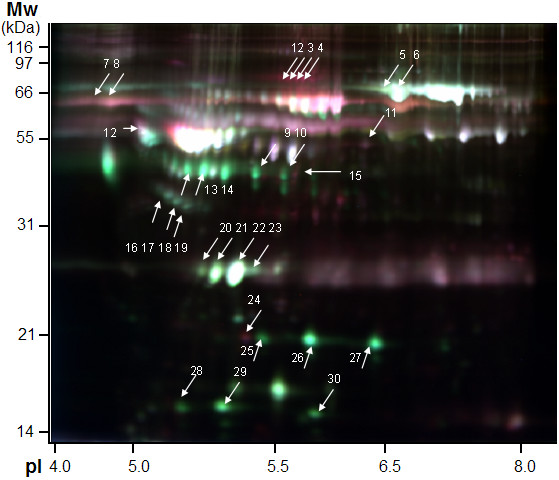
False-colored DIGE gel image of plasma proteins from normal and patient groups. Cy2 (blue) image of proteins from internal standard plasma; Cy3 (green) and Cy5 (red) image of proteins from plasma of different groups. The overlay images showed white spots containing proteins that have equal expression levels in each two group samples, red spots containing proteins with a higher expression and green spots containing proteins with a lower expression in the progressive phase of fibrosis. Spots for which the volume |ratio| ≥ 1.5 (t test) and P ≤ 0.05 (one-way ANOVA) based on DeCyder software analysis were identified by MS. In some cases, different spots were identified as the same protein.